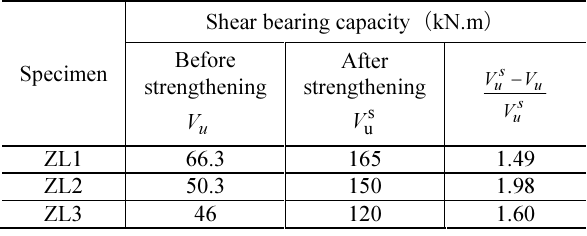
Table 6. Comparison of specimen shear capacity before and after strengthening Shear bearing capacity （ kN.m ） Specimen